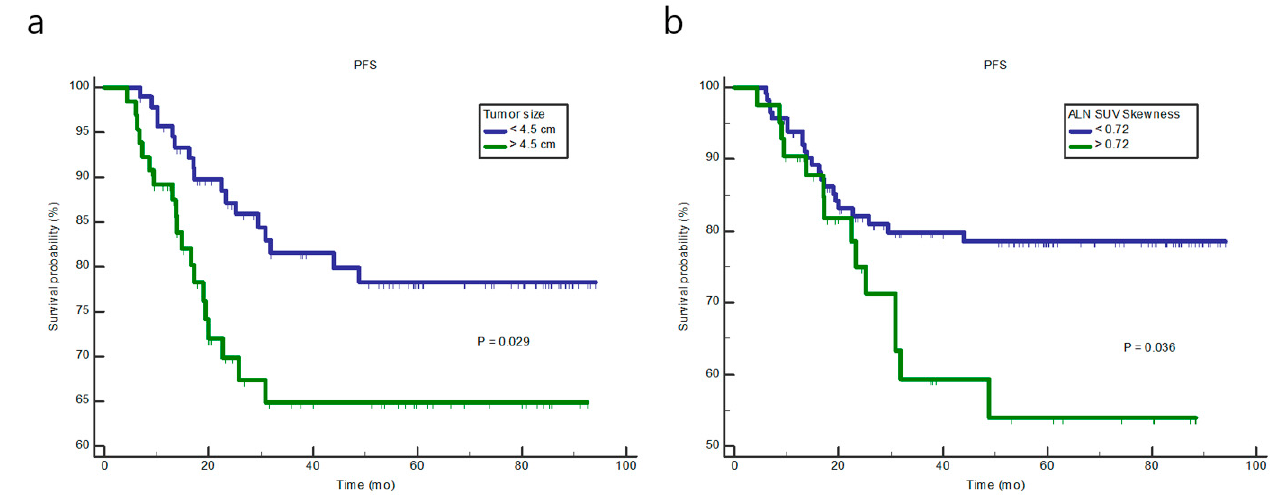
Figure 2. Kaplan–Meier analysis of progression-free survival according to tumor size ( a ) and axillary lymph node (ALN) skewness ( b ). Table 2. Univariate and multivariate analyses of predictive factors for progression-free survival.